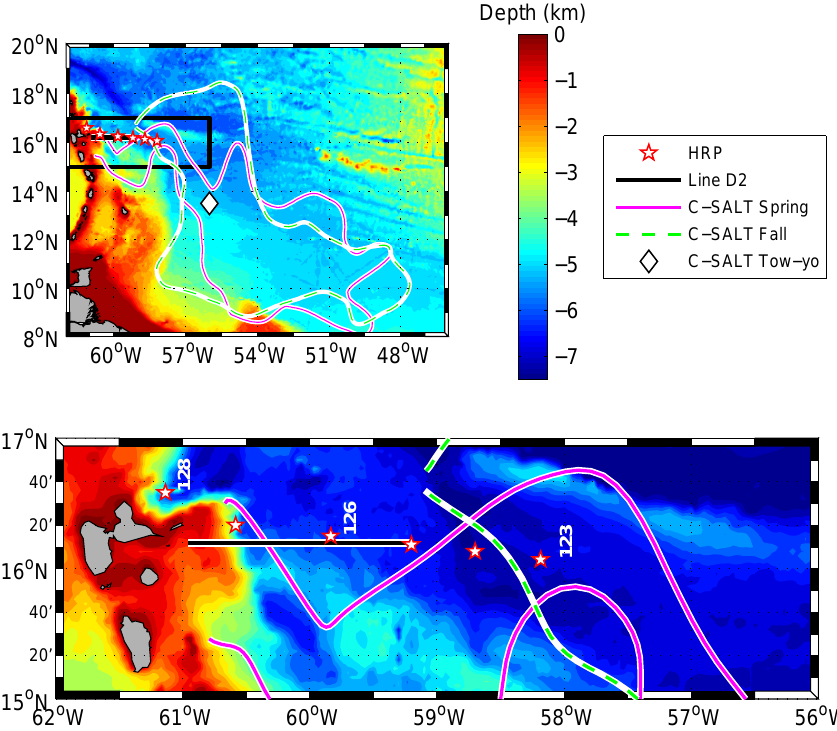
Fig. 1. Bathymetric map of the study area near the Lesser Antilles in the Caribbean Sea. Lower panel is a blow-up of the study region marked by the rectangle in the upper panel. Line D2 (black) is the transect of the 1998 seismic reflection survey. The stations where the high-resolution profiler (HRP) was deployed in 2001 are marked by red stars (dives 123 to 128). Dive 123 (easternmost) is used in the synthetic modeling (Sect. 2.3). Dive 125, at the eastern end of Line D2, is used to constrain the longevity of the layers. The spatial extent of strong staircases identified during the 1985 C-SALT experiment is shown for the spring (magenta) and fall (dashed green) surveys together with the C-SALT tow-yo location (diamond) (Schmitt et al.,